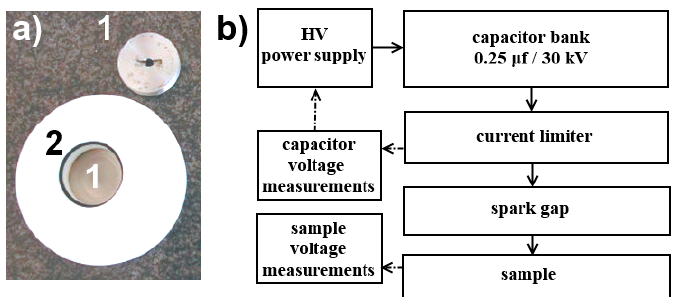
Figure 4. View of working chamber ( a ) and block diagram for HVED test stand ( b ). 1—electrodes; 2—juice container.